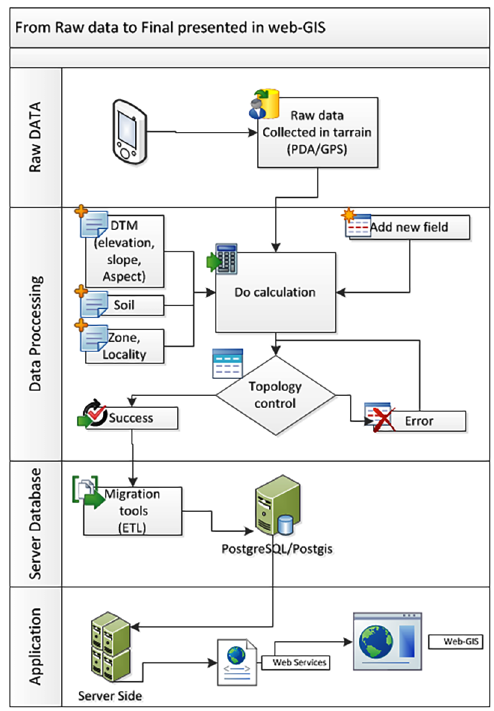
Figure 7. From raw data to Web GIS